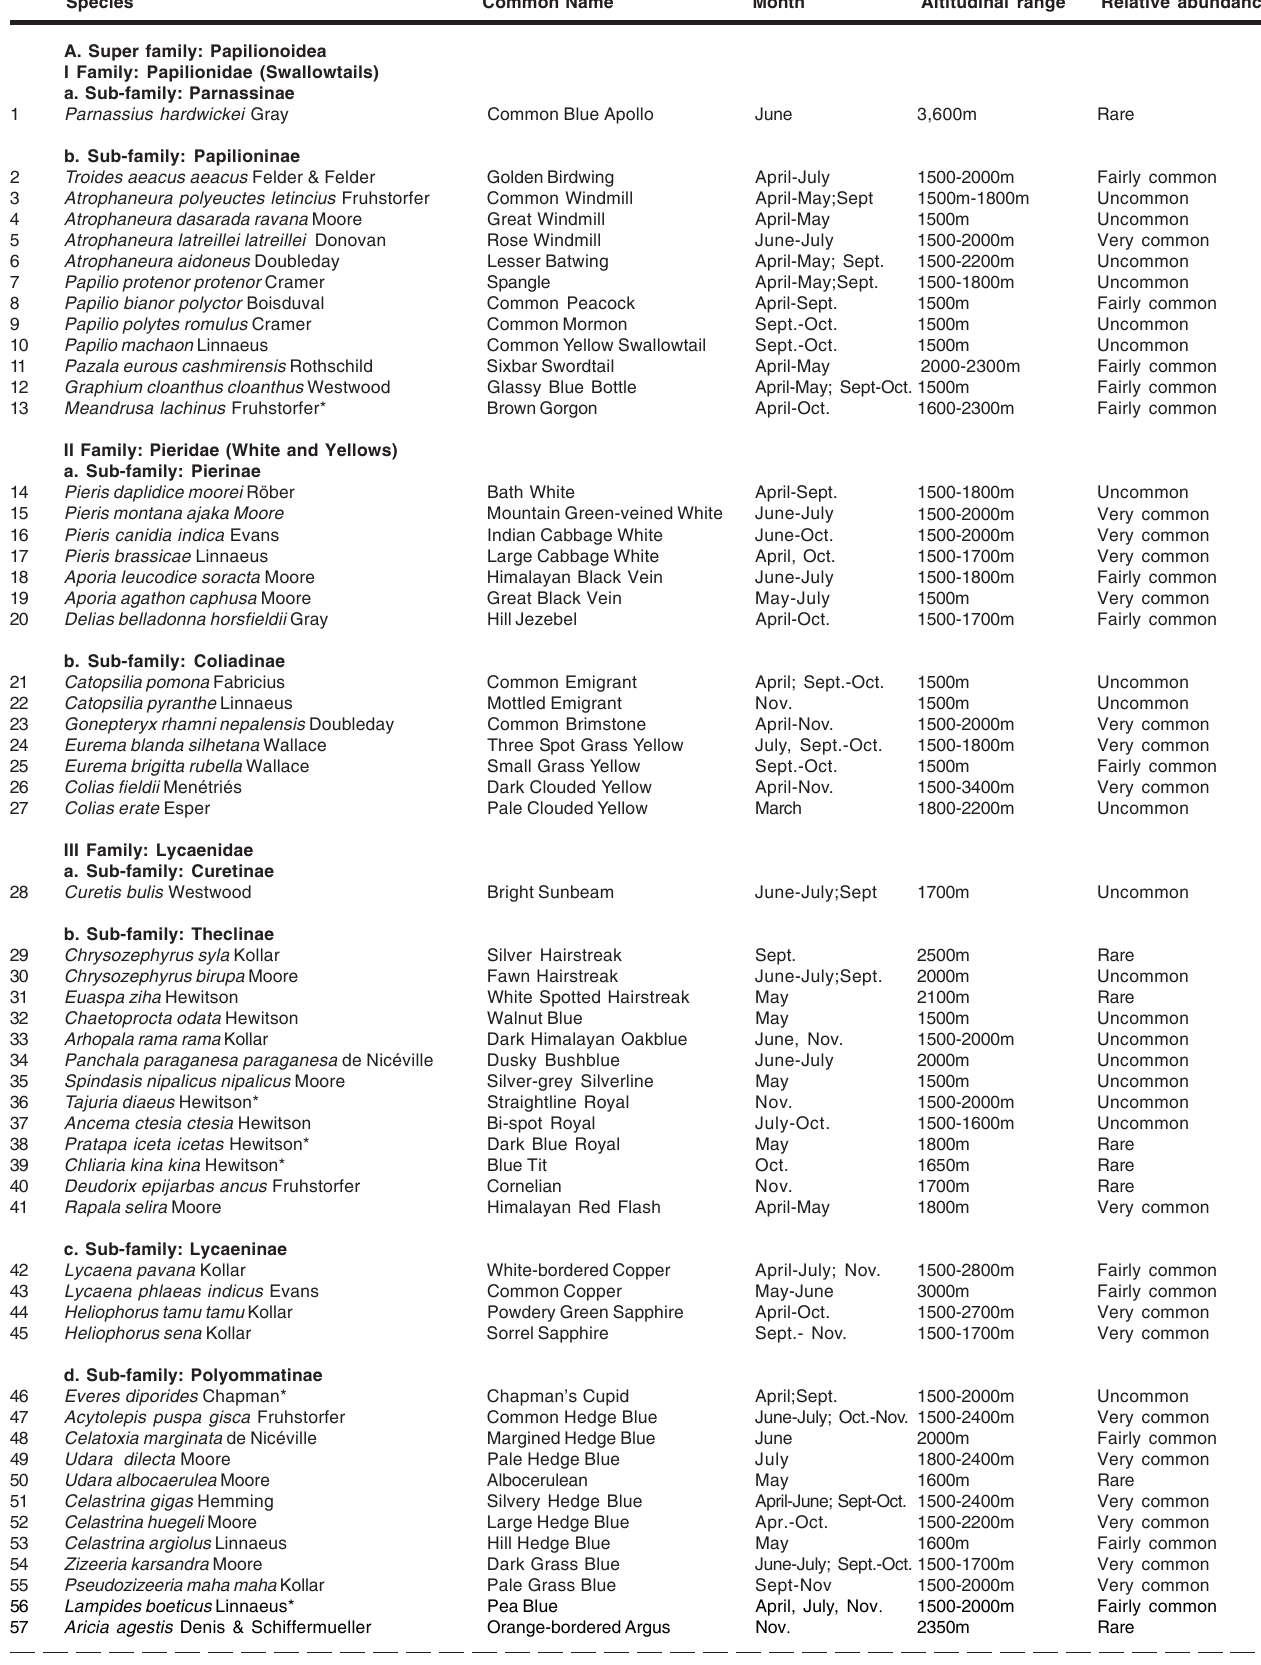
Table 1. Systematic list of butterflies (Rhopalocera) recorded from Kedarnath Musk Deer Reserve, Chamoli and Rudraprayag districts, Uttarakhand, India (May 2006 - September